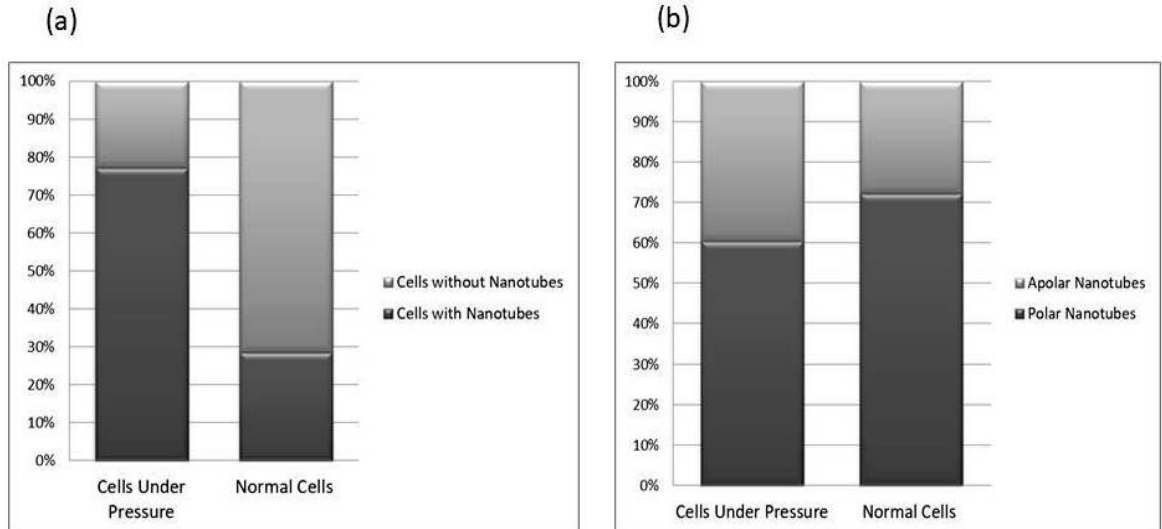
Figure 8. This comparative study of nanotube possession in cells. Image ( a ) reflects the total num- ber of nanotubes in cells grown in between two slides under a weight (15.45 g) and cells from the lower base of biofilm consortia without weight pressure (normal cells). The cells under-weight pressure possesses more nanotubes as compared to cells without pressure. The ( b ) side of the fig- ure depicted the position of nanotubes on cells. The majority of cells in both conditions possess polar nanotubes. Calculations were made on Gwyddion 2.60 using SEM and AFM data of more than 350 cells in total; all experiments were performed in